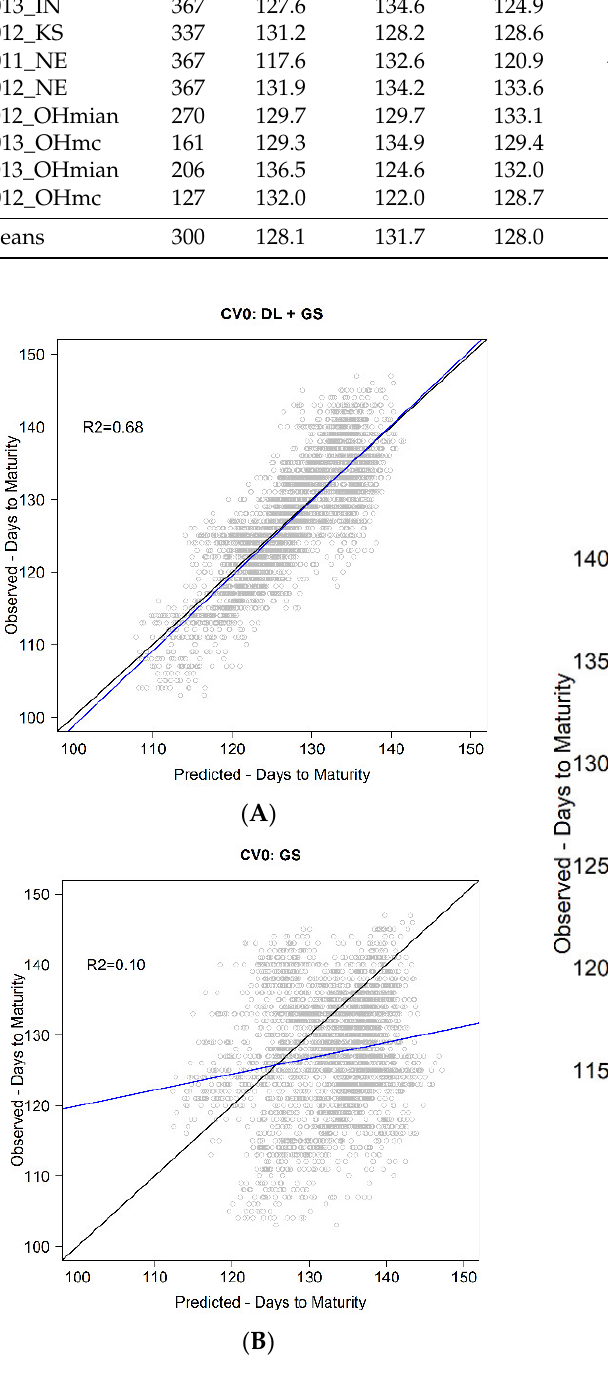
Figure 5. Scatterplot between the predicted (under the CV0 scheme with tested genotypes in unob- served environments) and observed DTMs of 367 soybean genotypes across 11 environments for the C-method ( A ) and the conventional GP model ( B ) and their corresponding environmental means ( C ). The blue line indicates the fitted line between the predicted and observed DTM values, the black line denotes the 1:1 line that represents the null hypothesis of no difference between the observed and predicted observations, and the environmental means are indicated with orange and blue sym- bols denoting paired O and P points of the C-method and the conventional GP model, respectively. 3.3. Predicting Untested Genotypes in Unobserved Environments (CV00) For predicting untested genotypes in unobserved environments (CV00), the BLUPs of the untested genotypes obtained with the conventional GP method were added to the estimated environmental means of the unobserved environments (CB-method: C + BLUPs). Table 2 presents the corresponding environmental means, PODEM, RMSE, and AC. The conventional GP model returned an RMSE of 7.8 days, the PODEM varied from −14.7 to 7.9 days, and the AC was 0.665. The CB-method produced an RMSE of 5.2 days, the PODEM ranged from −3.3 to 4.4 days, and the AC was 0.667. Similarly, as for the CV0 scheme (Figure 5), Figure 6 displays the results of the CB-method (6-A), the conventional GP model (6-B), and the predicted environmental means (6-C) of both